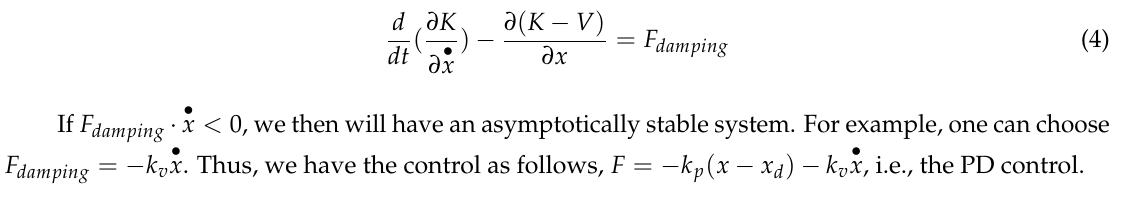
Figure 2. Lyapunov candidate function and corresponding state.